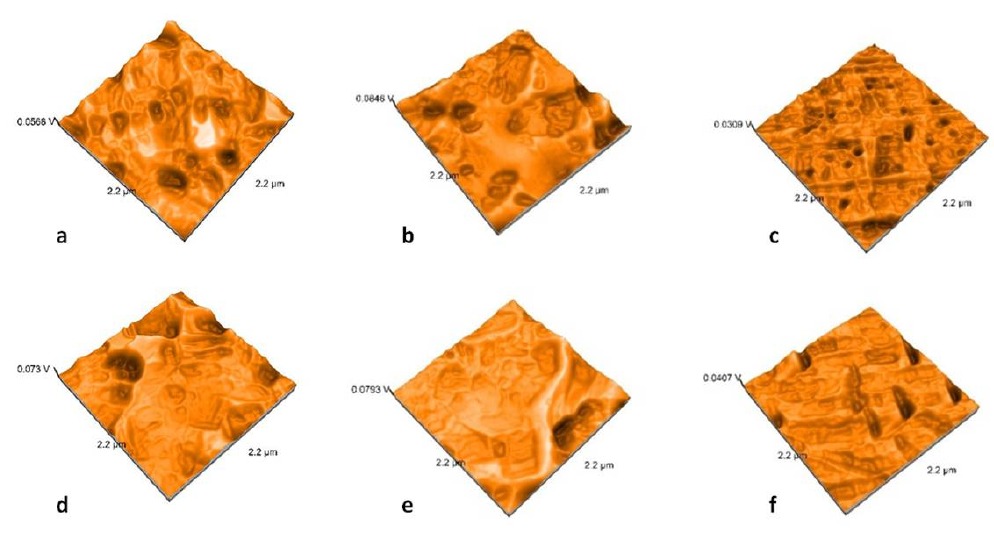
Figure 10. Atomic Force Microscopy (AFM) images of the polished samples: ( a ) LDS-P-P-HT, ( b ) LDS-P-P-MT, ( c ) LDS-M-P-MT, ( d ) ZLS-P-P-HT, ( e ) ZLS-P-P-MT, and ( f )